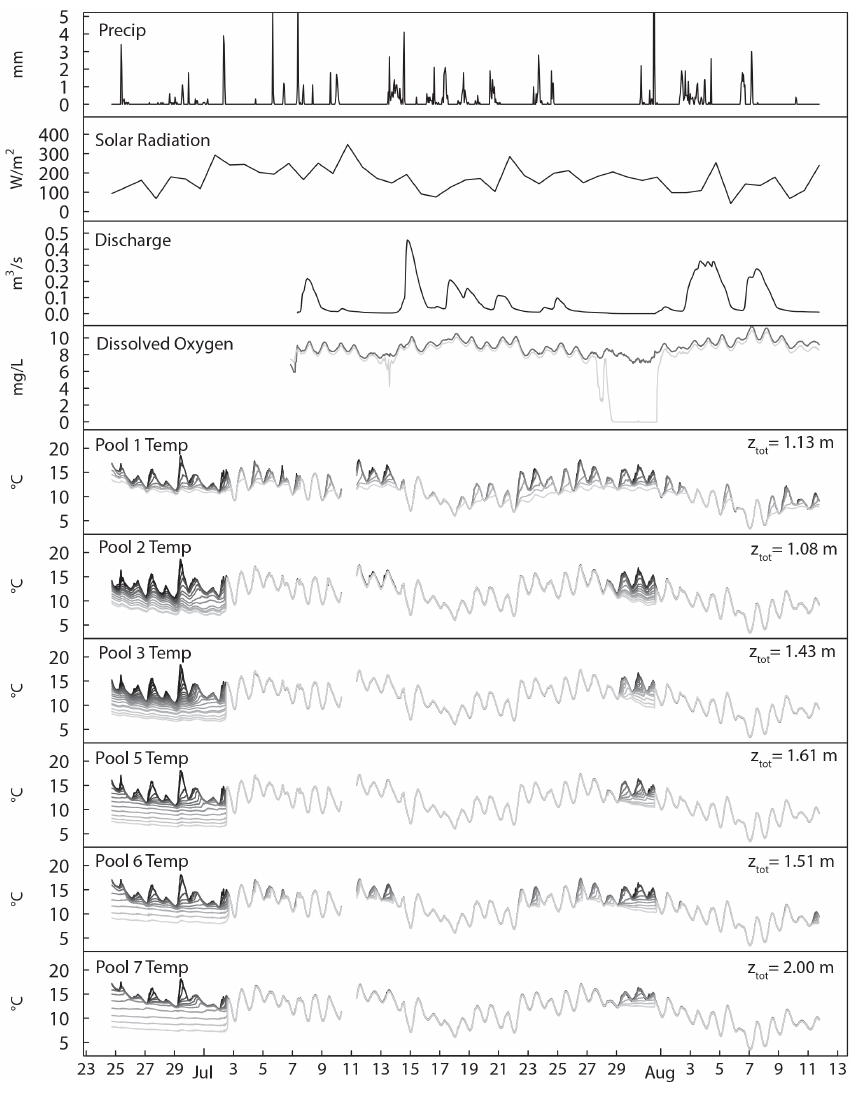
Figure 4. Imnavait Creek precipitation, solar radiation, discharge (at location downstream of study reach), dissolved oxygen in pool 2 top and bottom, and vertical arrays (VA) of temperature sensors within each study pool ( P ) in summer 2012. The darkest lines represent the sensor at the top of the water column; subsequent lines become lighter with depth of each sensor. The sensors were placed in each pool starting 5 to 15cm from the bottom of the pool and then at intervals ranging from 5 to 50cm over the depth of each pool ( z tot ) as indicated in the